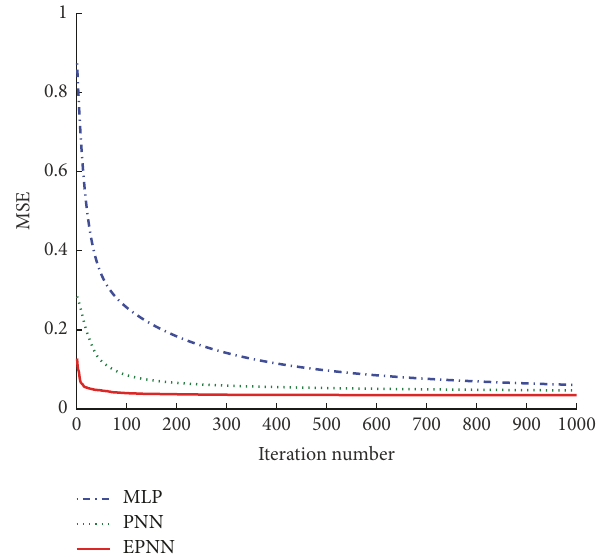
Figure 4: The convergency curve of the Qualitative Bankruptcy data set.